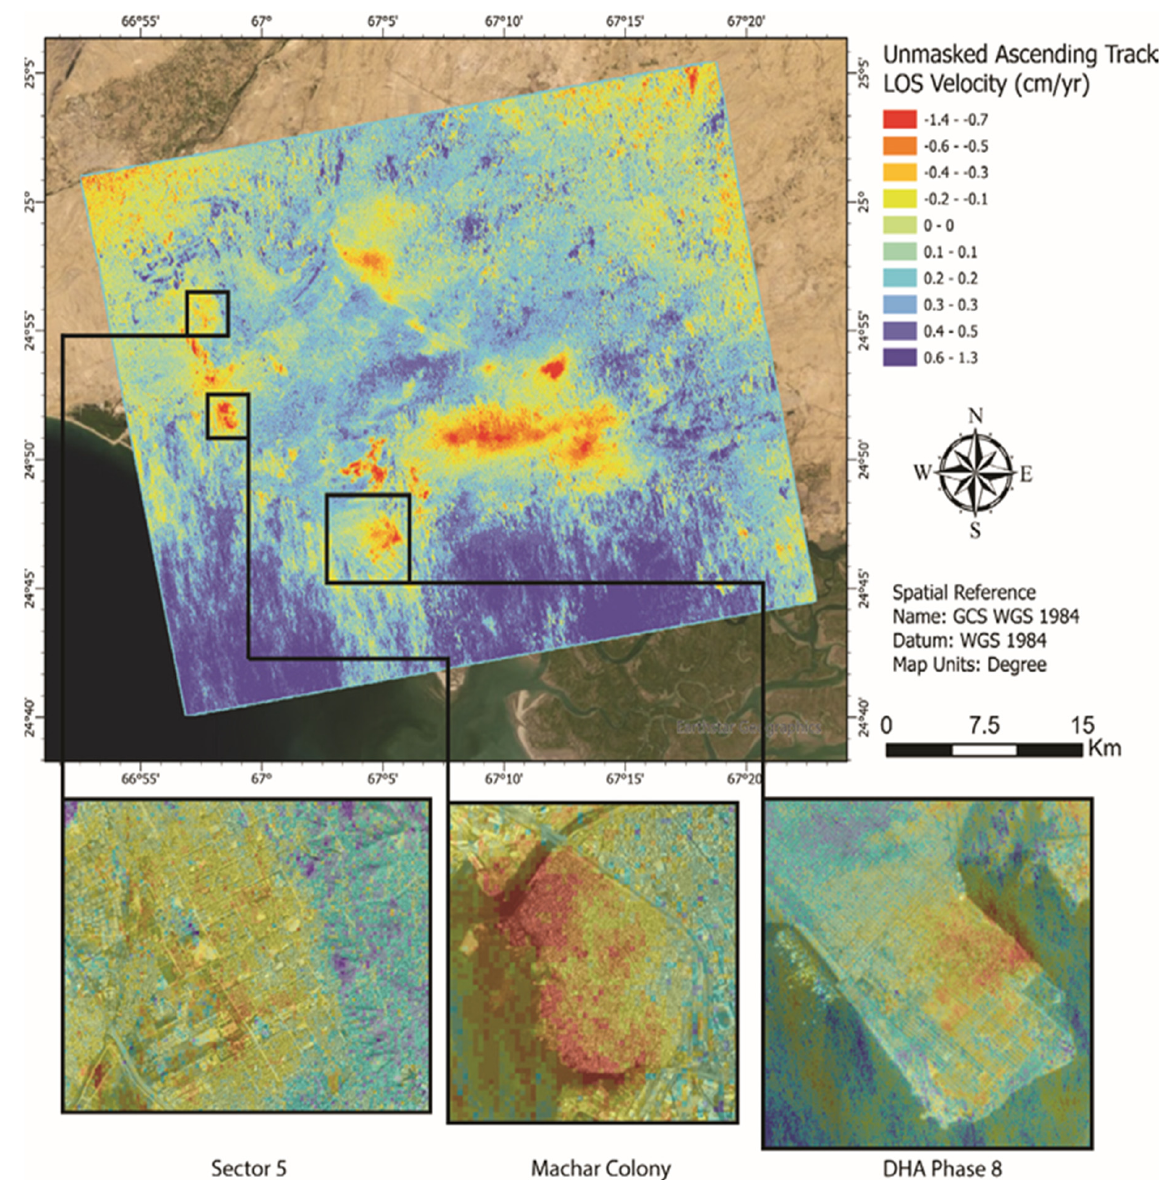
Figure 12. Unmasked ascending track LOS velocity with areas of consideration highlighted.